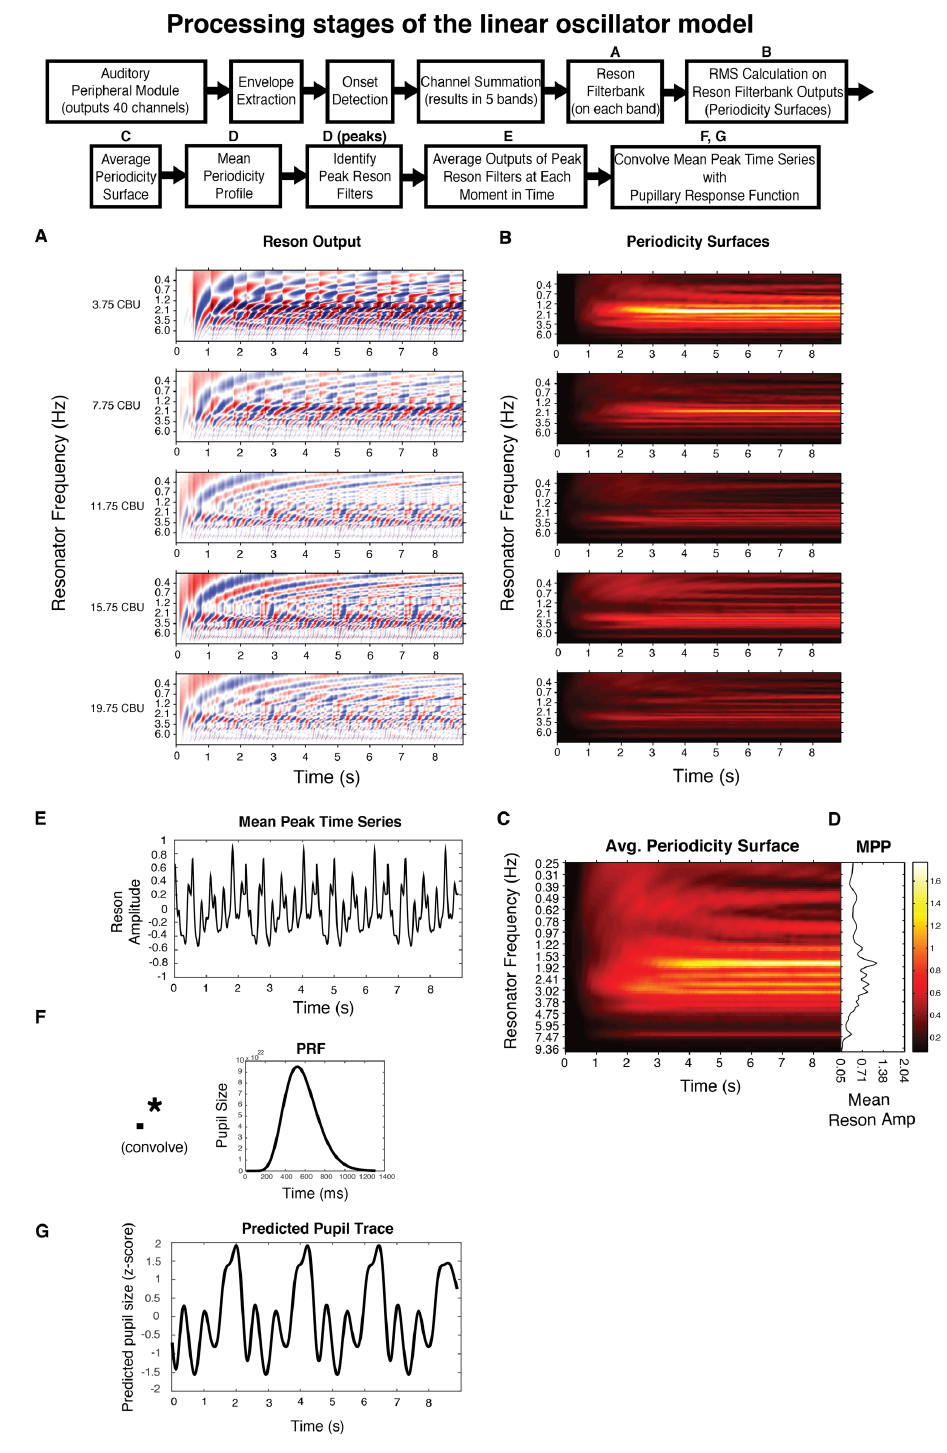
Figure 2. Boxes represent processing stages of the linear oscillator model; those labeled with a letter have a correspond- ing plot below. Please see Linear oscillator model predictions for full details. All plots are for stimulus